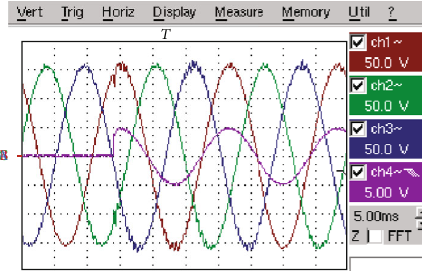
Figure 8: Dynamic response of the proposed hybrid controller under 100% rising load changes: load phase voltages, ch1-ch3 (50 V/div); phase “ a ” of load currents, ch4